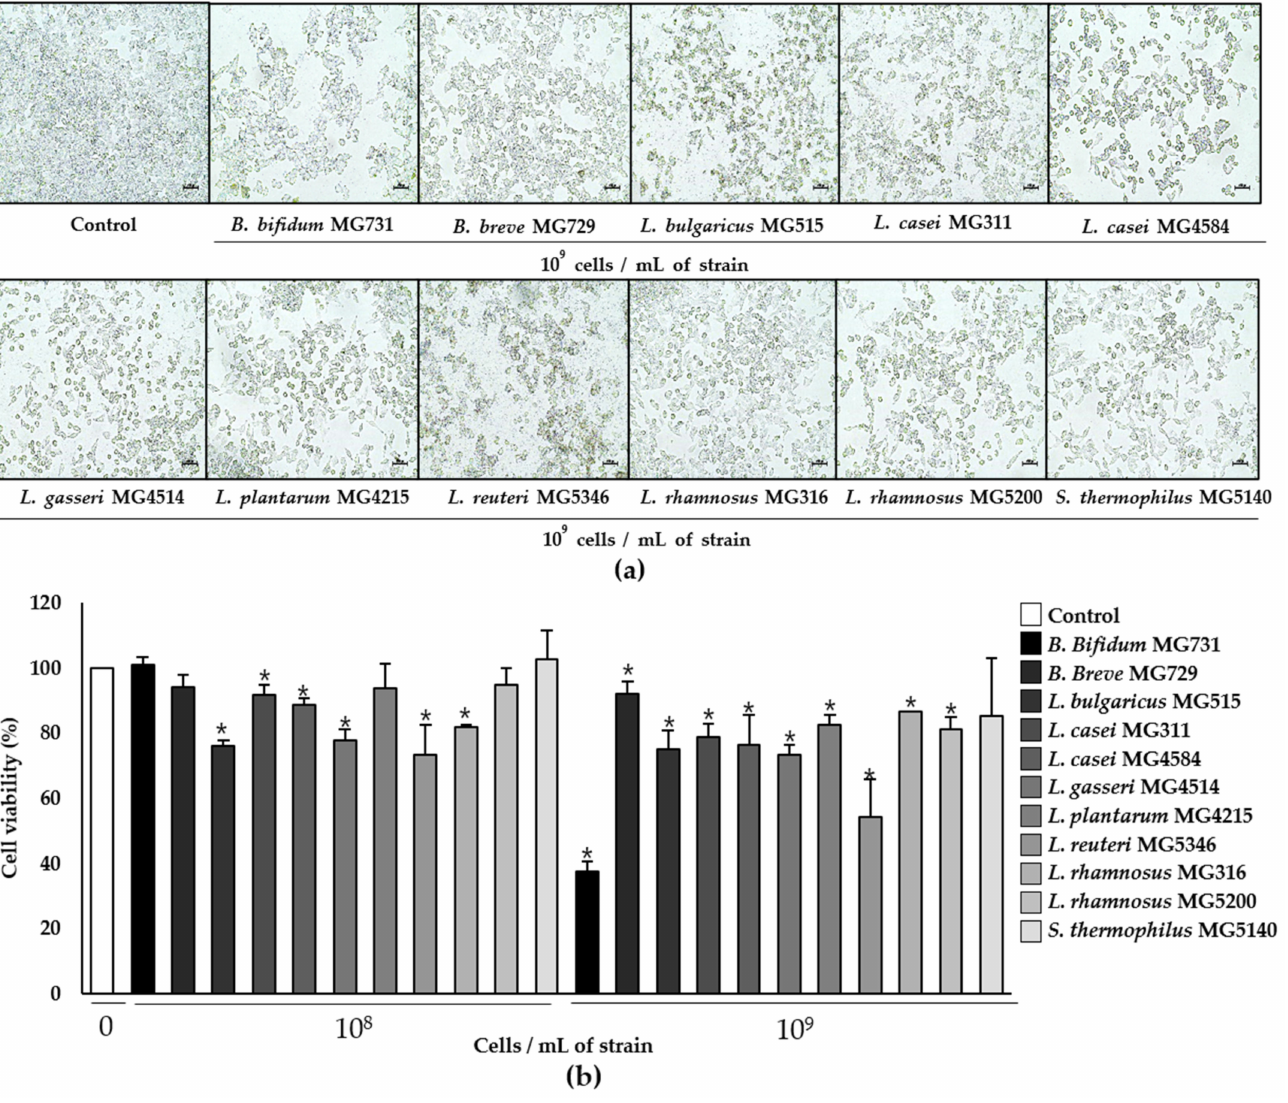
Figure 1. Cytotoxicity of heat-killed Bifidobacterium and Lactobacillus against human colorectal carci- noma RKO cells analyzed by MTT assay. ( a ) Cell morphology and ( b ) cell viability (%). The scale bar represents 200 px. Data represent mean ± SD ( n = 3), * p < 0.05 vs.